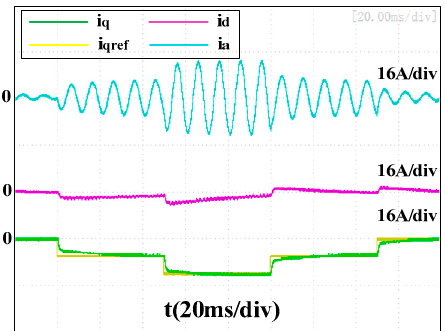
Figure 11. d-q axis current waveform of the conventional current controller without decoupling at 6000 rpm with Kp = 500 π Ls.